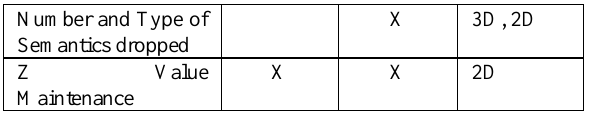
Table 2 . Metadata for Information Loss.